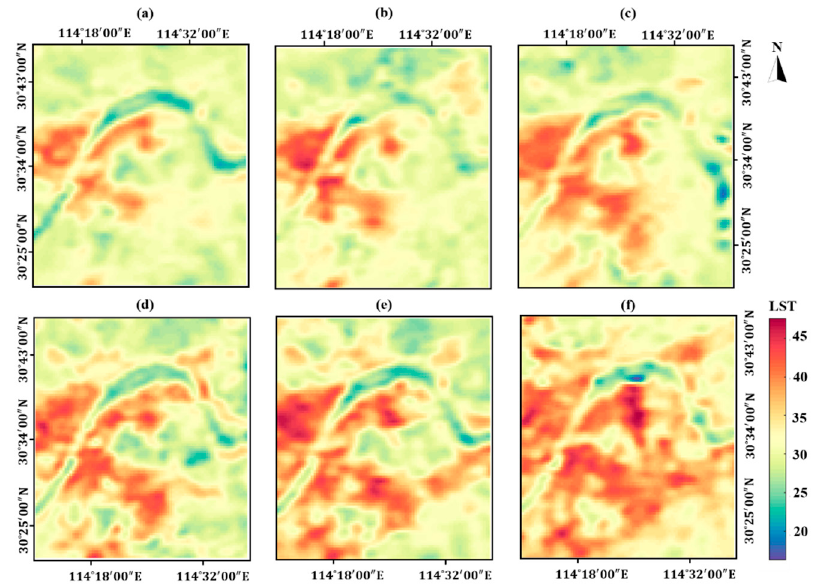
Figure 6. The MTGP extracted monthly LST patterns in Wuhan from 2002 to 2017. ( a ) 2002; ( b ) 2005; ( c ) 2008; ( d ) 2011; ( e ) 2014; ( f ) 2017.